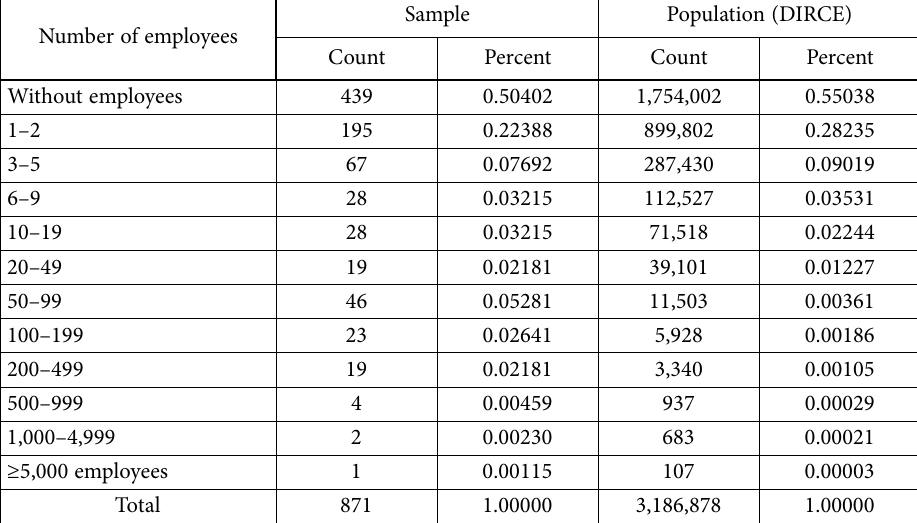
Table 1. Size of firms (source: own compilation and INE